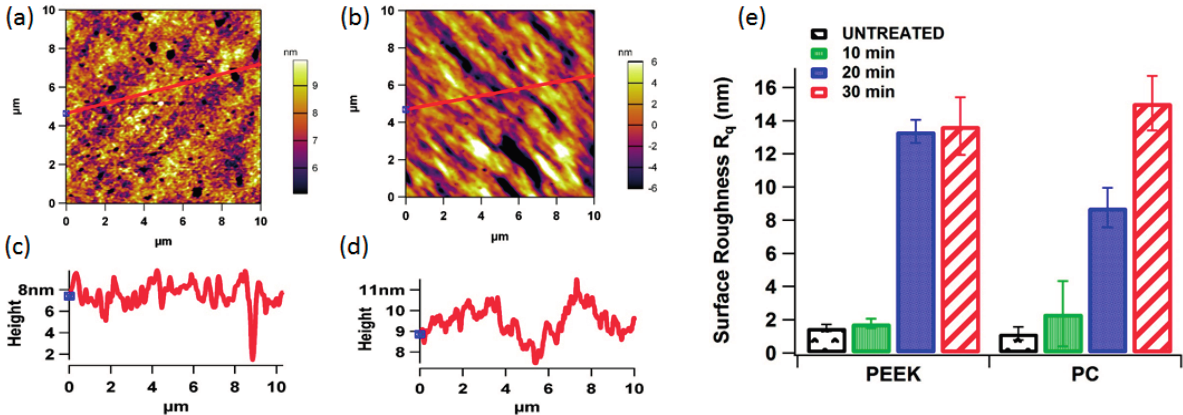
Figure 5. Representative 2D non-contact mode AFM images (10 µm × 10 µm) for untreated ( a ) PEEK and ( b ) PC; ( c , d ) surface roughness line profiles for untreated PEEK and PC; ( e ) bar graph showing the surface roughness of each polymer vs. plasma treatment